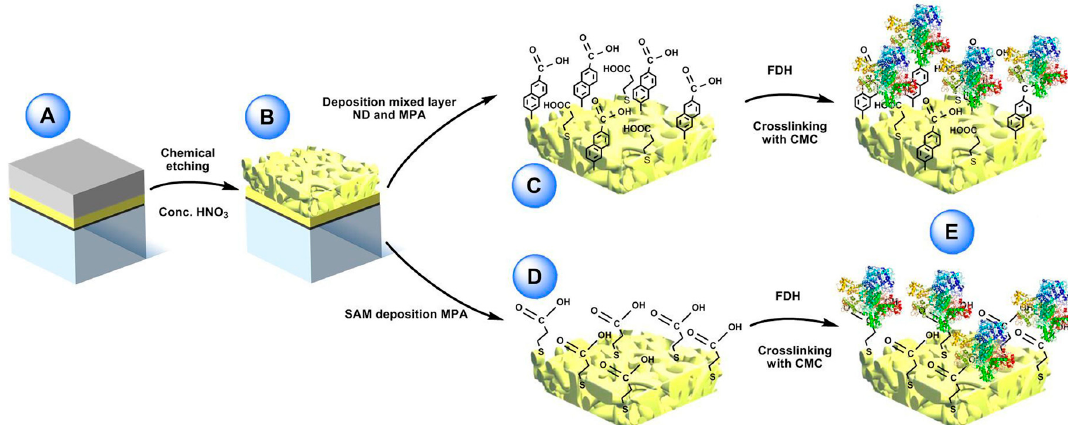
Figure 5. ( A ) Sputtered glass sheet with layers of titanium, pure gold and gold/silver alloy (bottom to top). ( B ) nano-PG electrode surface post-dealloying by concentrated nitric acid. ( C ) Electrochemical